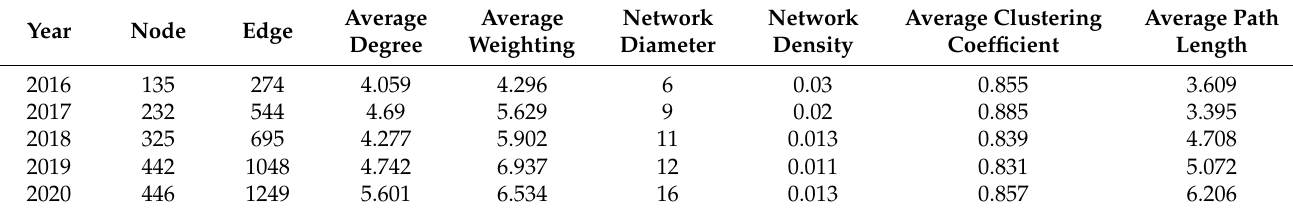
Table 1. Cluster Index Statistics for the Digital Construction